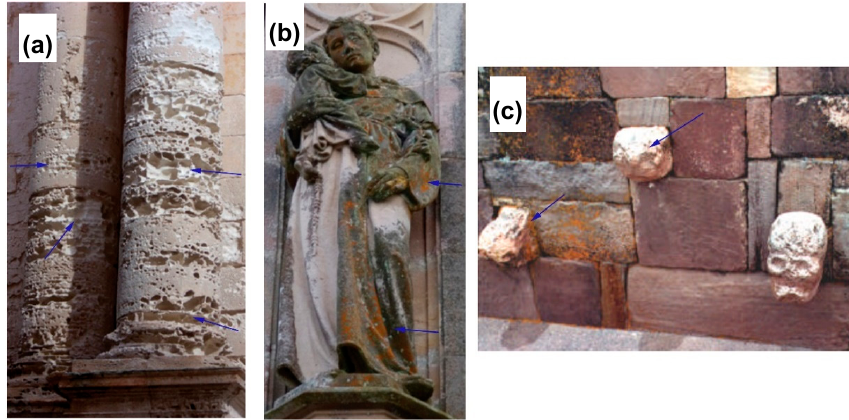
Figure 1. Degraded historic buildings by ( a ) a massive salt weathering in building stone, and ( b ) staining and microbial growth. Modified with permission from [27]. 2017, Consejo Superior de Investigaciones Cient í ficas (CSIC). ( c ) Skull shape, completely lost with the presence of orange lichen. Modified with permission from